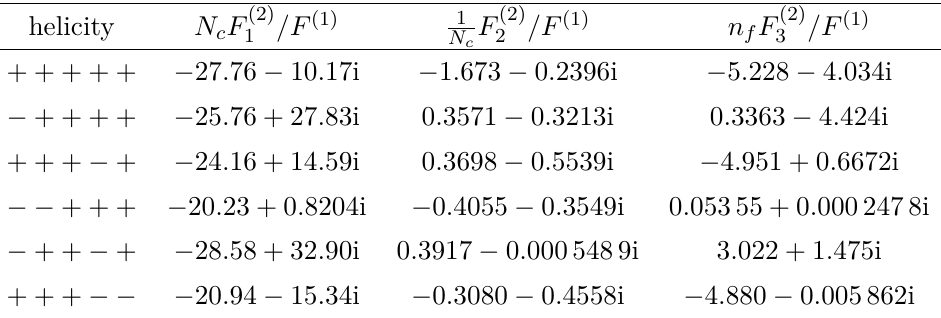
Table 2 . Numerical values of the partial amplitudes for the six independent helicities at the benchmark point in eq. (6.3). Values are quoted with N c = 3 and n f = 5 , to four significant figures.